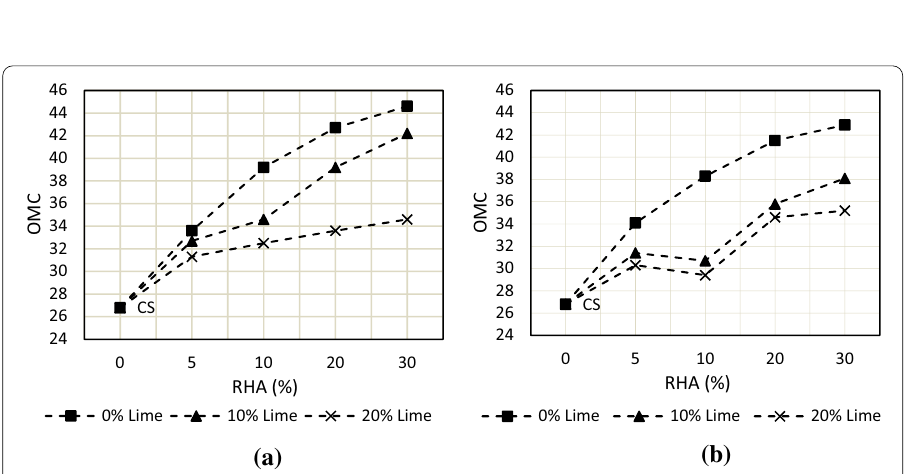
Fig. 4 Effect of RHA and lime mixture on Optimum Moisture Content (OMC) a Soon after mixing b 28 days after